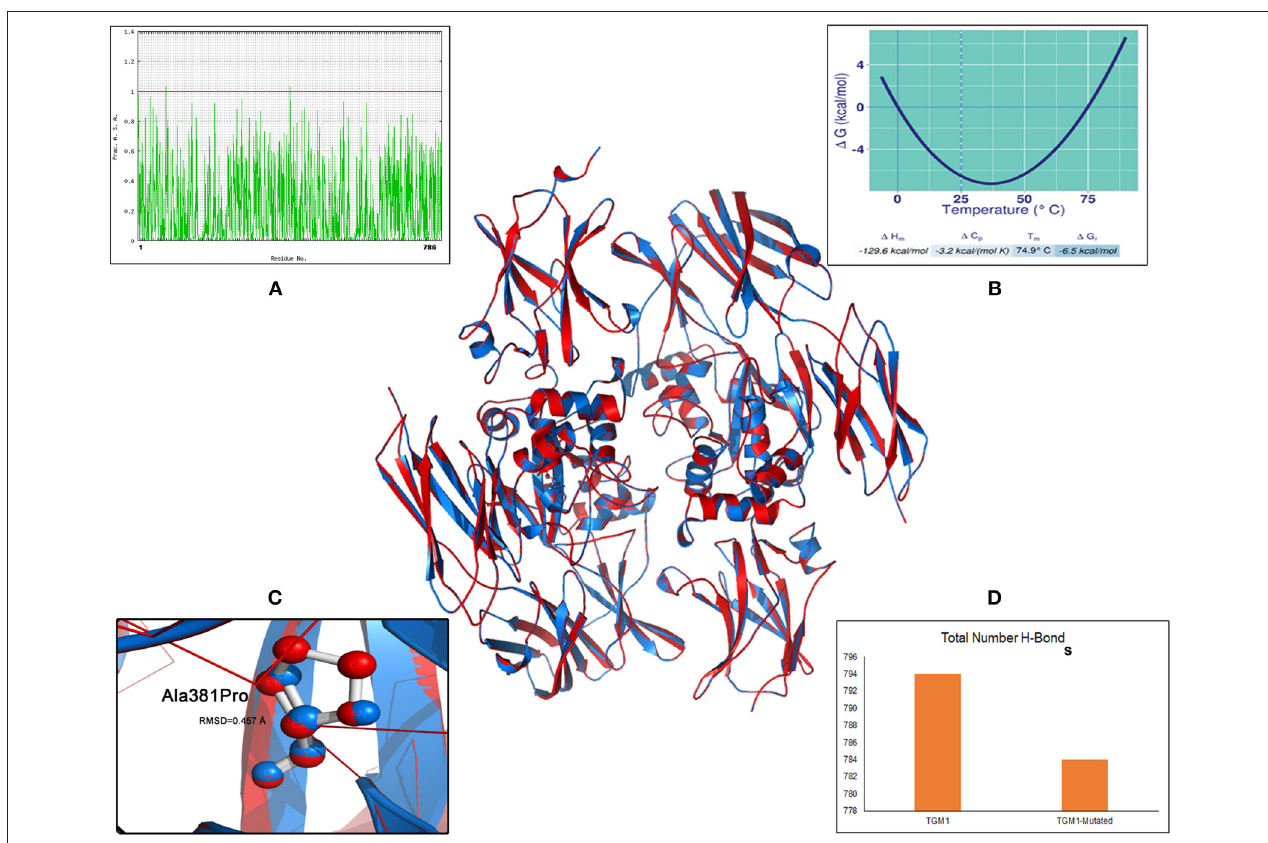
FIGURE 3 | Molecular view of TGM1 altered (p.Ala381Pro) protein model and its biophysical characteristics. Solvent accessibility graph (A) Stability curve (B) RMSD value (C) number of hydrogen bonds (D)